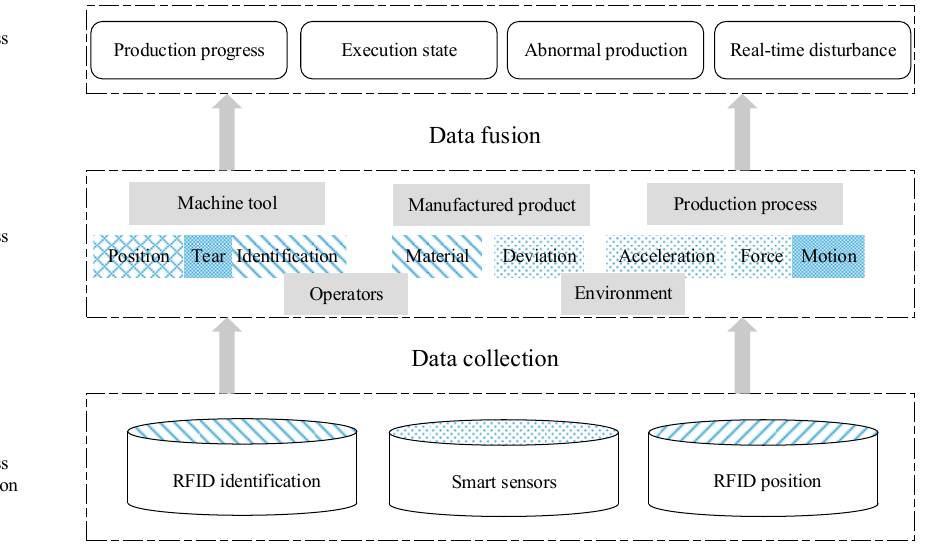
Figure 2. Operational data fusion structure.